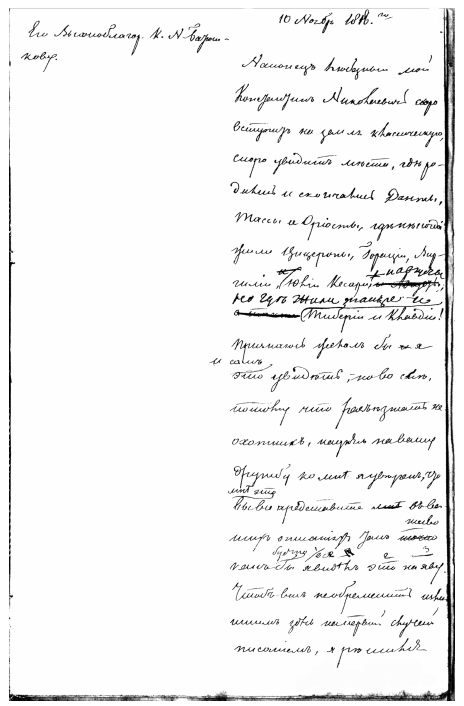
Figure 17. Aleksei Olenin. A letter to Konstantin Batiushkov, 10 November 1818. State Archive of the Russian Federation,